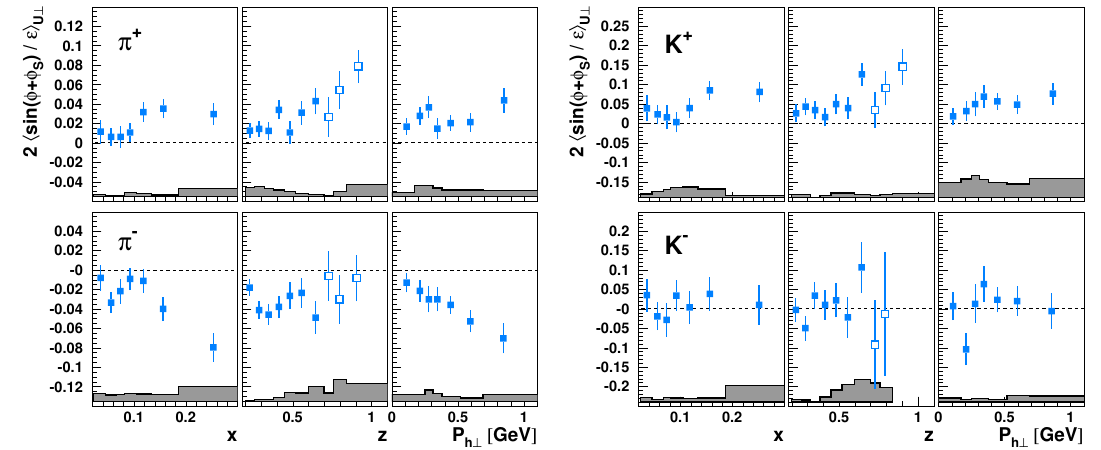
Figure 8 . Collins SFA for charged mesons (left: pions; right: kaons) presented either in bins of x , z , or P h ⊥ . Data at large values of z , marked by open points in the z projection, are not included in the other projections. Systematic uncertainties are given as bands, not including the additional scale uncertainty of 7.3% due to the precision of the target-polarization